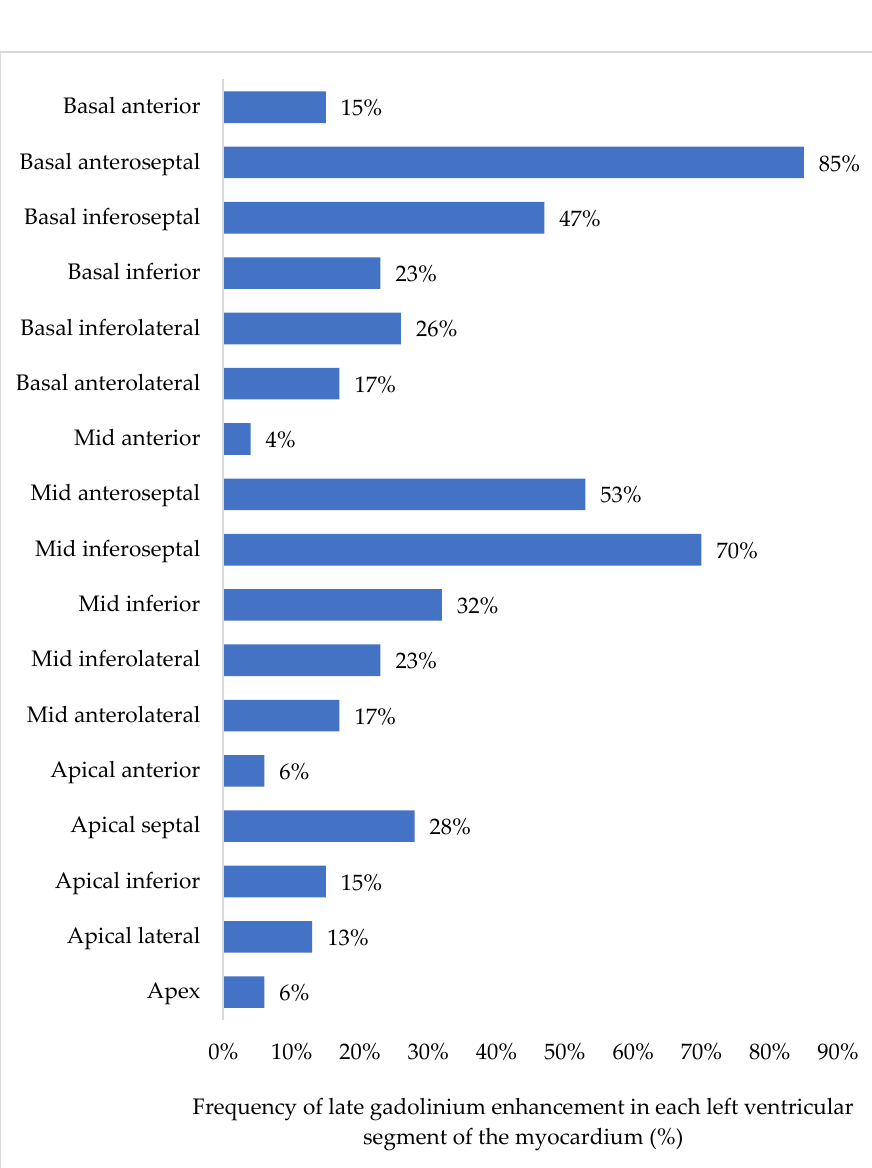
Figure 3. Distribution of late gadolinium enhancement in the left ventricular myocardial segments. The bars demonstrate the percentage of segments with LGE. In 85% of IDCM patients, LGE was visualised in the basal anteroseptal segment. There were 46 IDCM patients with LGE in one or more segments; therefore, the cumulative percentage will be >100%.